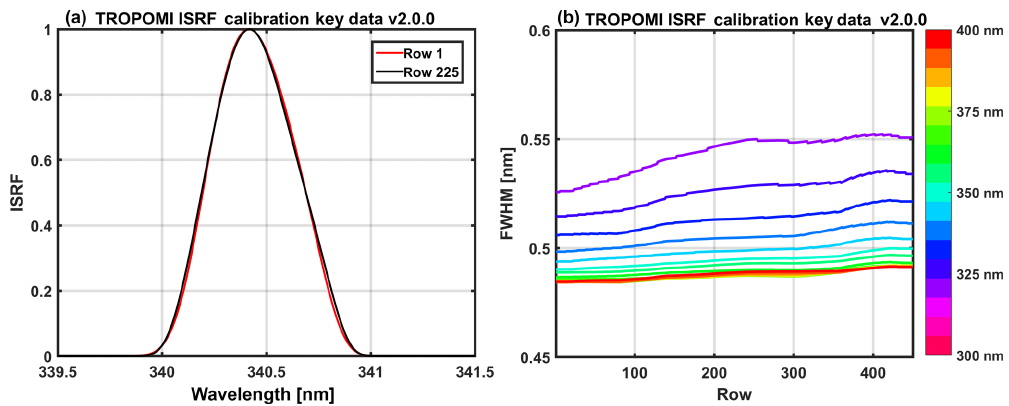
Figure 5. (a) Examples of TROPOMI slit functions around 340nm, for row 1 and row 225. (b) TROPOMI spectral resolution in channel 3, as a function of the row and the wavelength, derived from the instrument key data ISFR